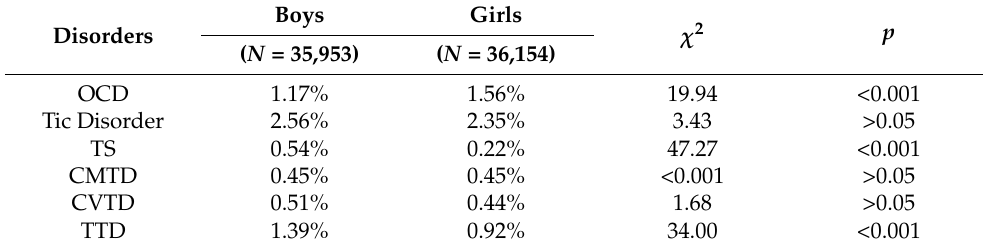
Table 2. Sex difference in OCD, TD and TD subtypes.